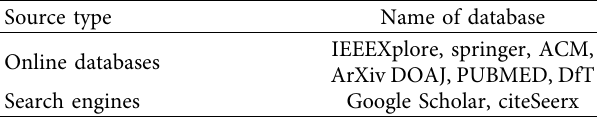
Table 3: List of data